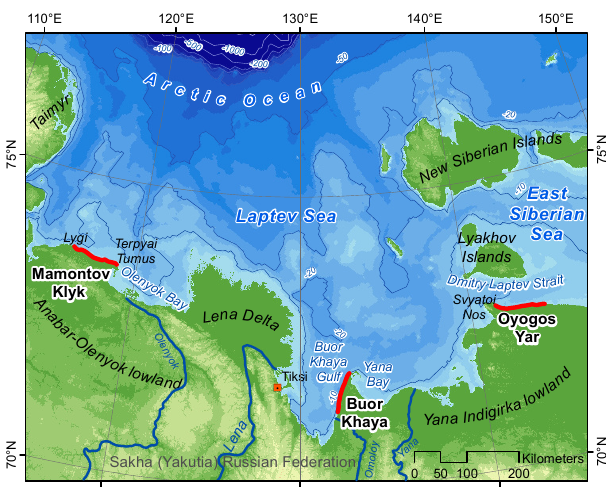
Fig. 1. Location of the study sites within the Laptev Sea region. Analyzed coastline sections are marked as red lines and comprise from west to east: Mamontov Klyk, Buor Khaya and Oyogos